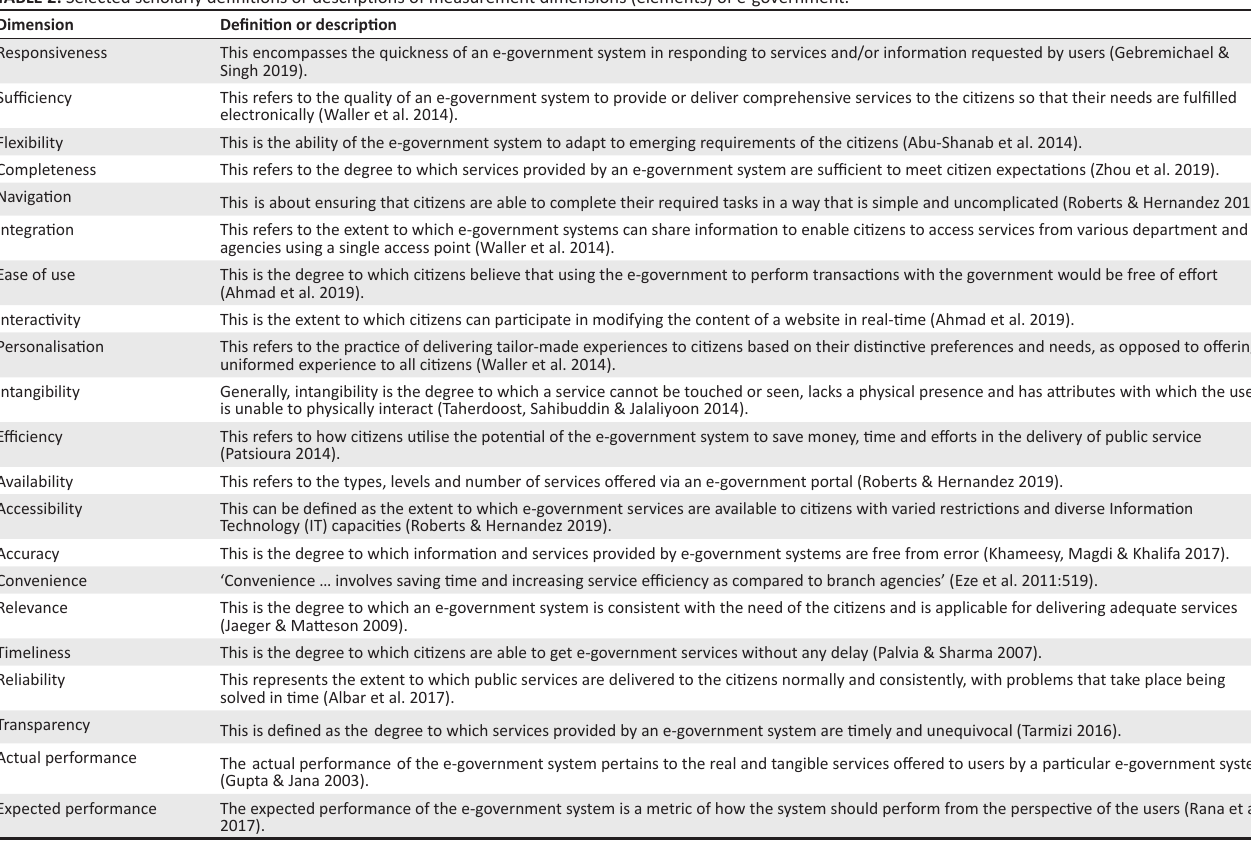
TABLE 2: Selected scholarly definitions or descriptions of measurement dimensions (elements) of e-government.